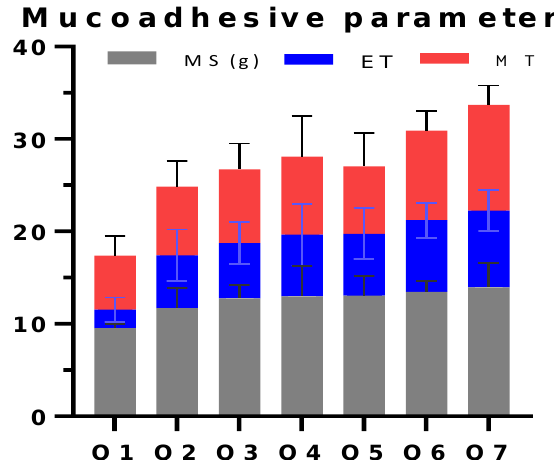
Figure 5. Mucoadhesive characterization of formulations prepared in the study.